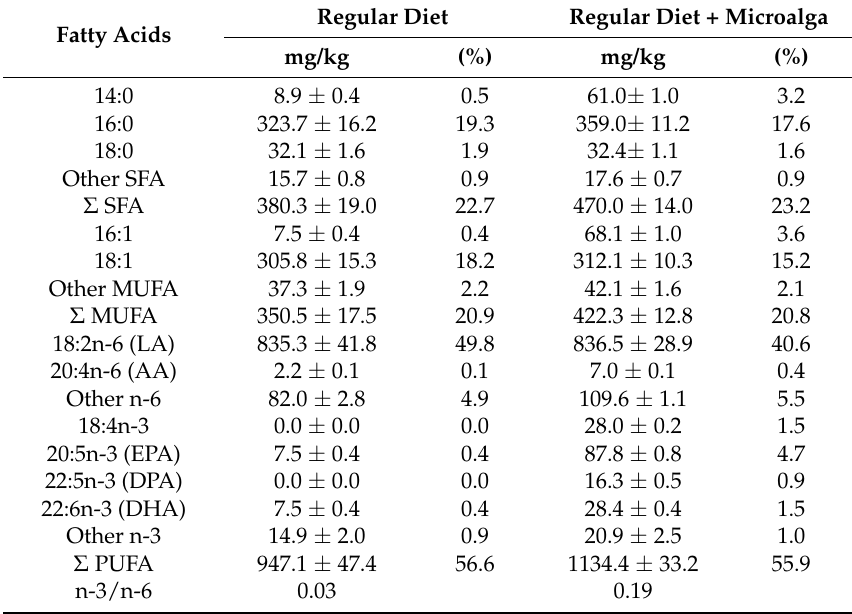
Table 1. Fatty acid profile (mg/kg of animal body-weight) of rats’ daily diets: regular diet (fed chow) and Diacronema vlkianum dose (2.5g/kg) with regular diet. Percentage (%) represents each FA ratio of total ingested FA on each diet